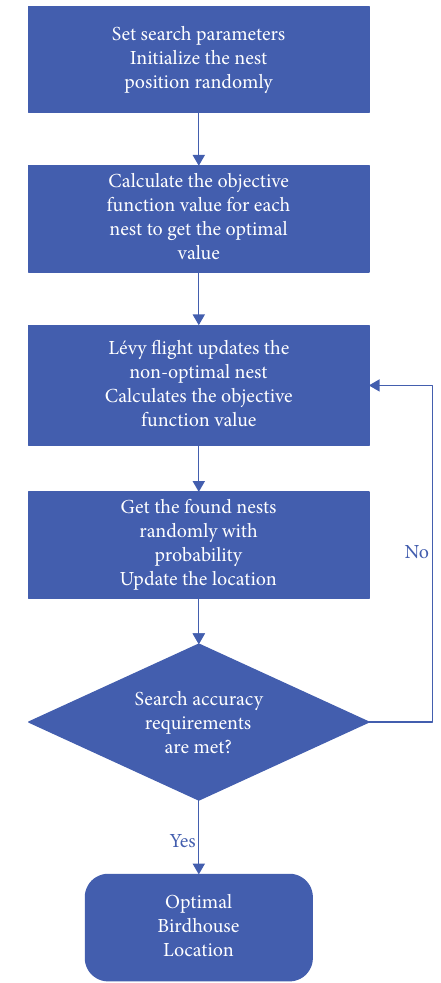
8: The fl owchart of the CS